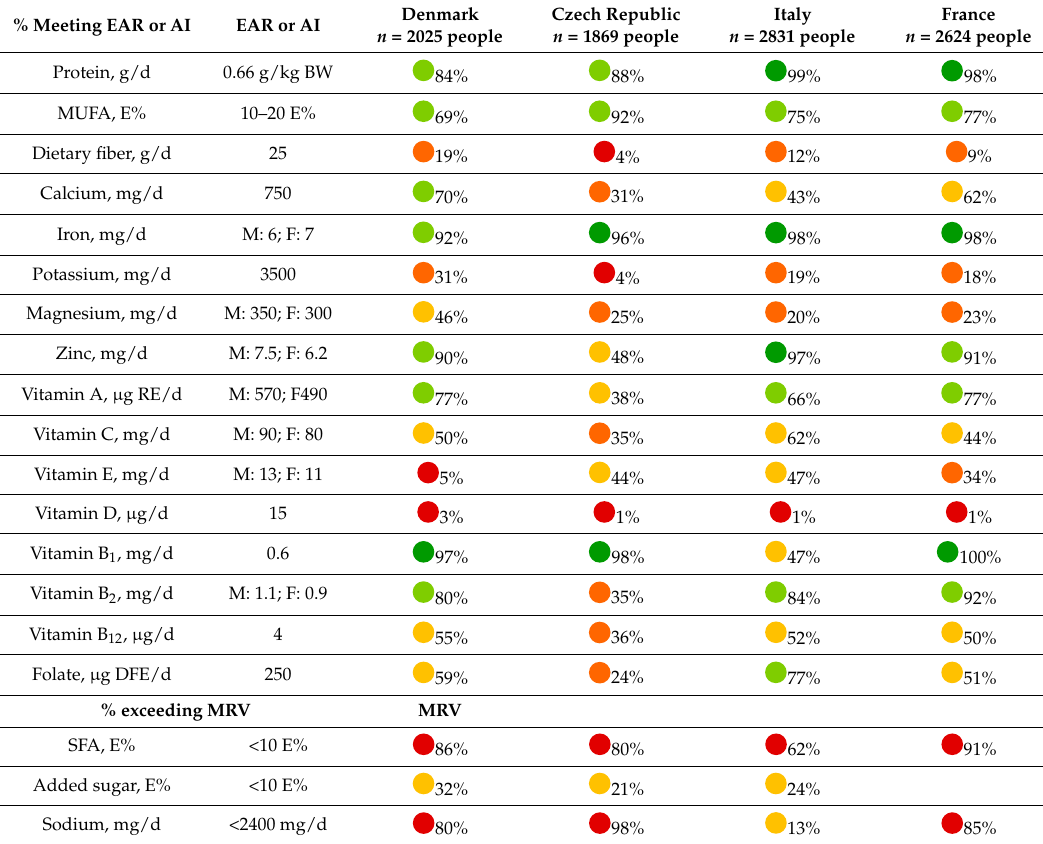
Table 1. Percentage of adults with nutrient intakes meeting the estimated average requirement (EAR) or adequate intake (AI) or exceeding the maximum reference value (MRV) [12].